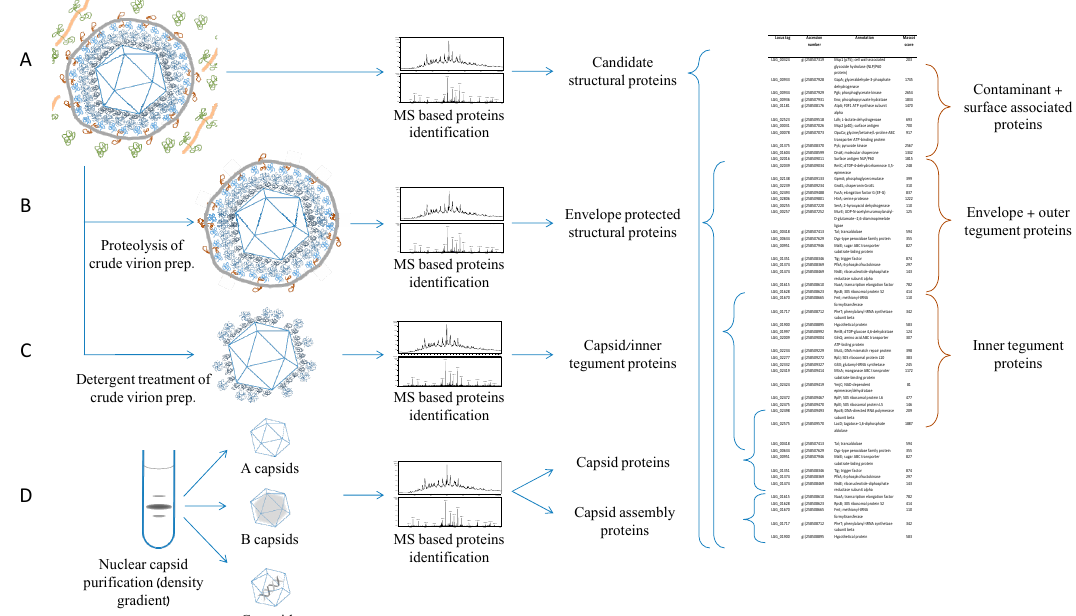
Figure 3. Treatment and fractionation of the virions and nuclear capsids permits accurate determination of the structural proteome. To remove contaminant proteins that could be wrongly identified as structural proteins ( A ), purified virions can be submitted to proteolysis during the isolation procedure ( B ). This procedure permits removal of all of the proteins not protected by the envelope and thus considered as contaminants or surface associated proteins. To determine localization of the proteins inside the virions, detergent treatment to remove the envelope and the so called “outer tegument” proteins has also been shown to be efficient ( C ). Inner tegument proteins are in this case identified in the capsid/tegument fraction. Capsid proteins can generally be predicted based on homology with characterized capsid proteins but can also be identified from purified immature caspids, which help understand the capsid maturation process ( D ). Combination of all or parts of these strategies also allows indirect classification of proteins as “contaminant or surface associated,” “envelope or outer tegument proteins” and “inner tegument proteins” as shown by the red brackets.